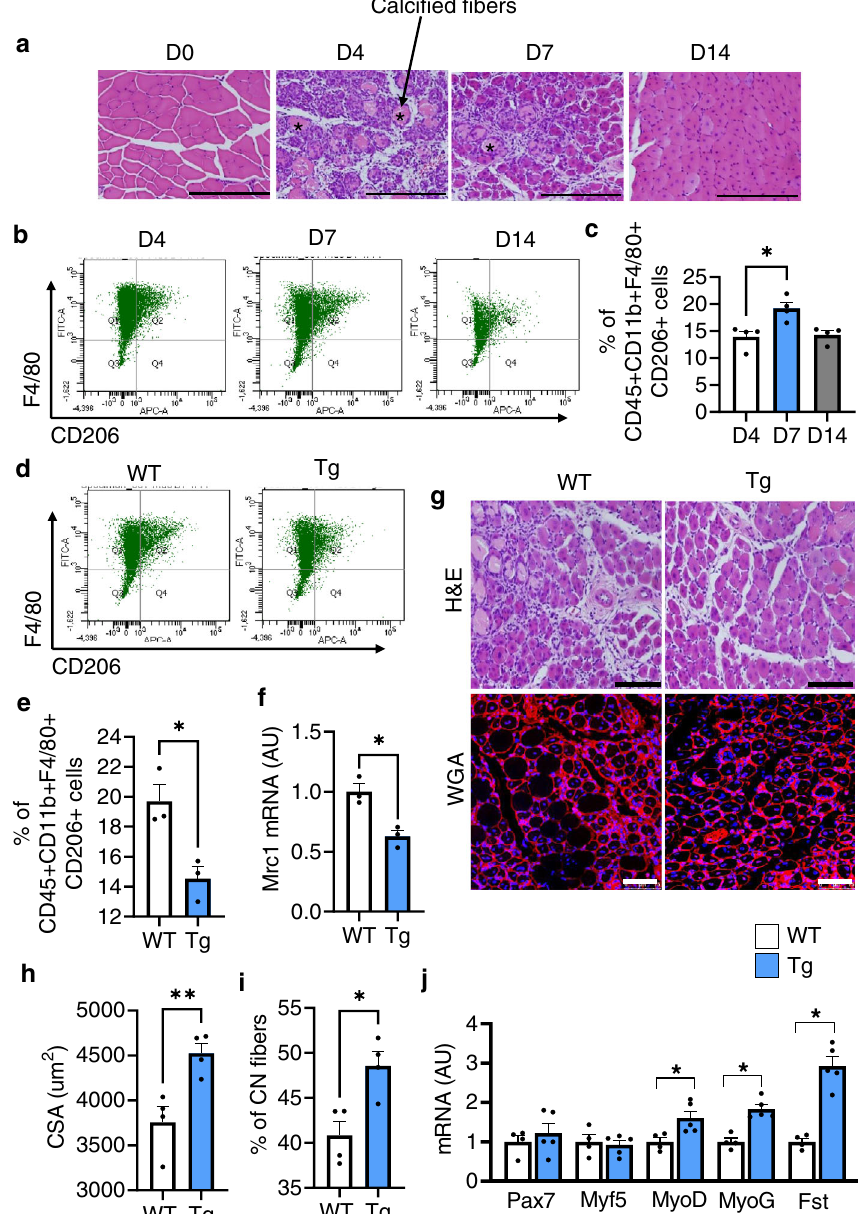
Fig. 1 | Depletion of CD206 + M2-like M Φ promotes muscle